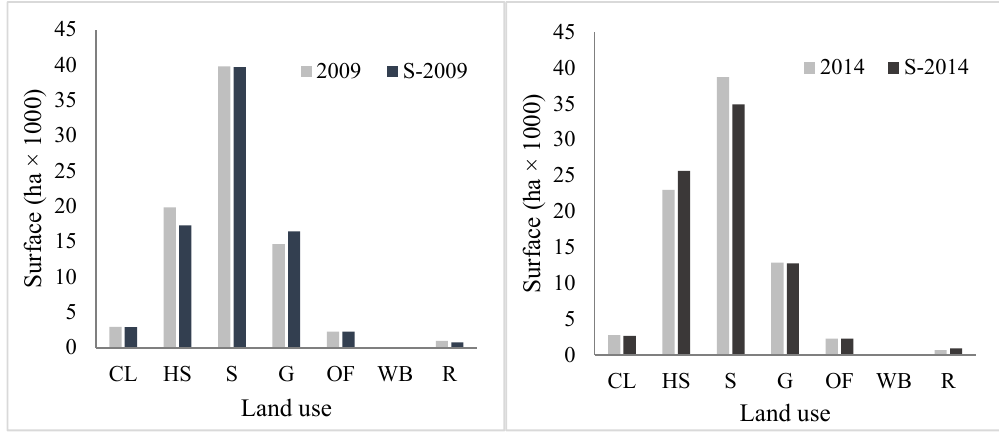
Figure 9. Comparison of simulated and real land uses for: 2009 ( left ); and 2014 ( right ). CL, Croplands; HS, Human settlements; OF, Oak forest; WB, Water bodies; S, Shrublands; G, Grasslands; R, Riparian vegetation.